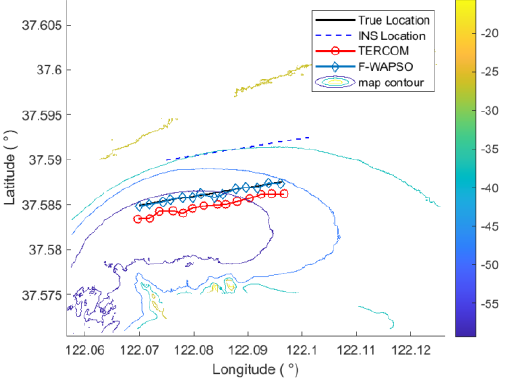
Figure 4. Trajectory A matching results of the two algorithms.